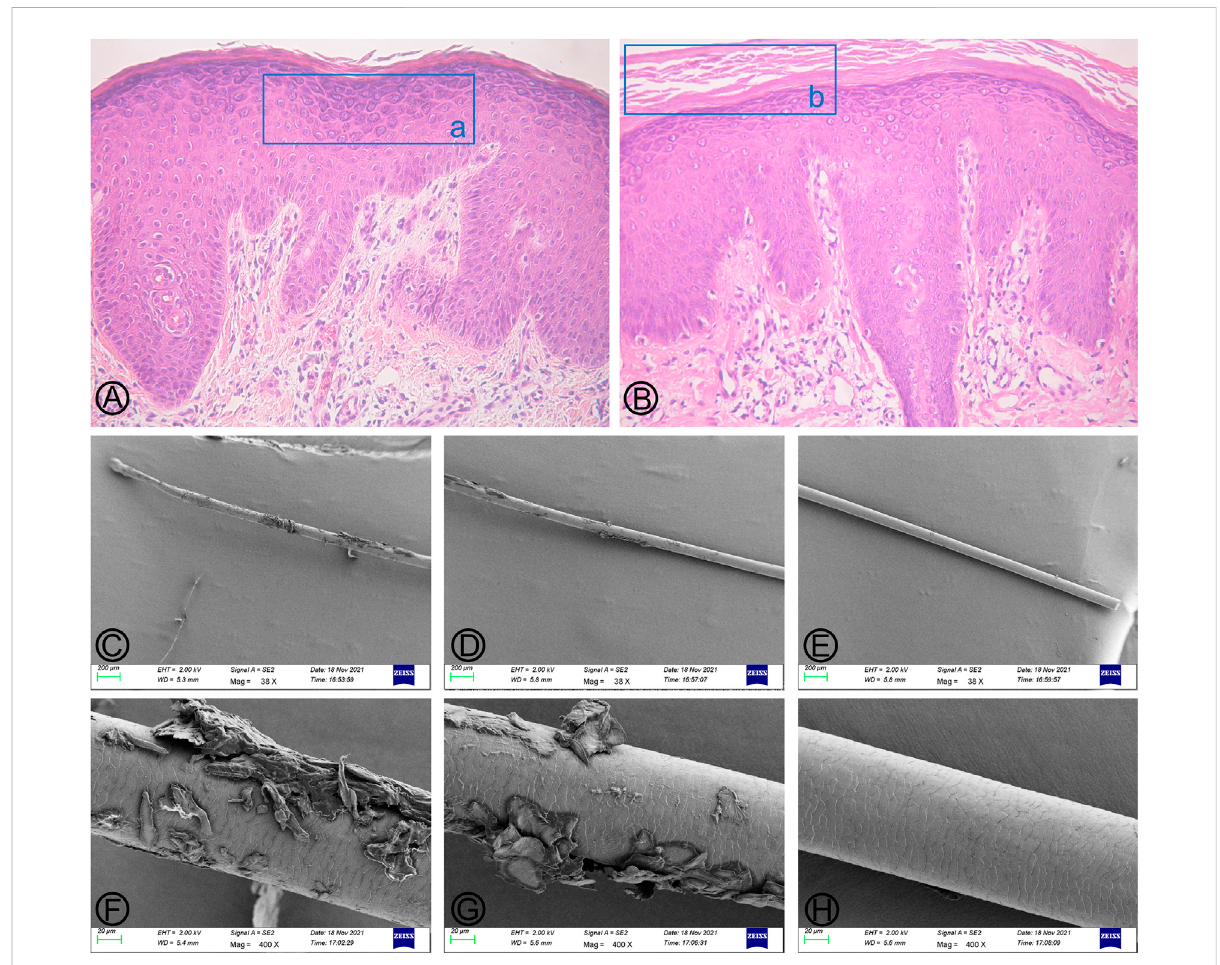
FIGURE 2 Findings of histopathological and hair scanning electron microscopy (SEM). (A,B) (HE×100) Marked hyperkeratosis, parakeratosis, hypergranulosis, and acanthosis, as well as dermal perivascular lymphocytic in fi ltrates. The blue box (a) indicates hypergranulosis, and the blue box (b) indicates hyperkeratosis. (C – E) (Mag×38); (F – H) (Mag×400) No characteristic bamboo hair was found under SEM. Some hair cuticles were damaged, deformed, and exfoliated in the two-thirds of the lower part of the hair shaft, while the hair cuticles were normal on the upper one- third of the hair